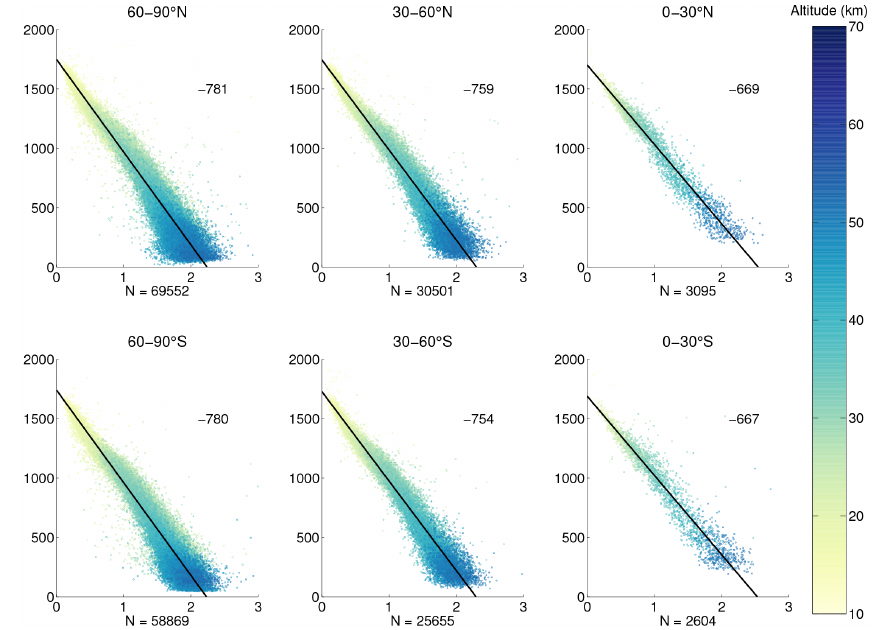
Figure 1. CH 4 (ppb, y axis) vs. HF (ppb, x axis) from ACE-FTS measurements taken between 2004–2012, binned by zonal bands. The slopes of the linear regression are in the upper right-hand corner, and number of data points ( N ) are listed below each plot.